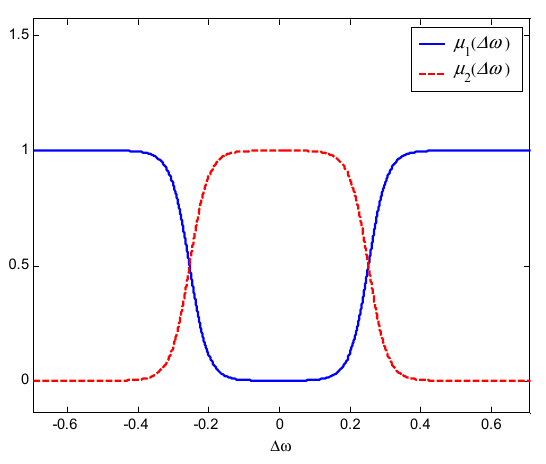
Figure 5. The membership functions.